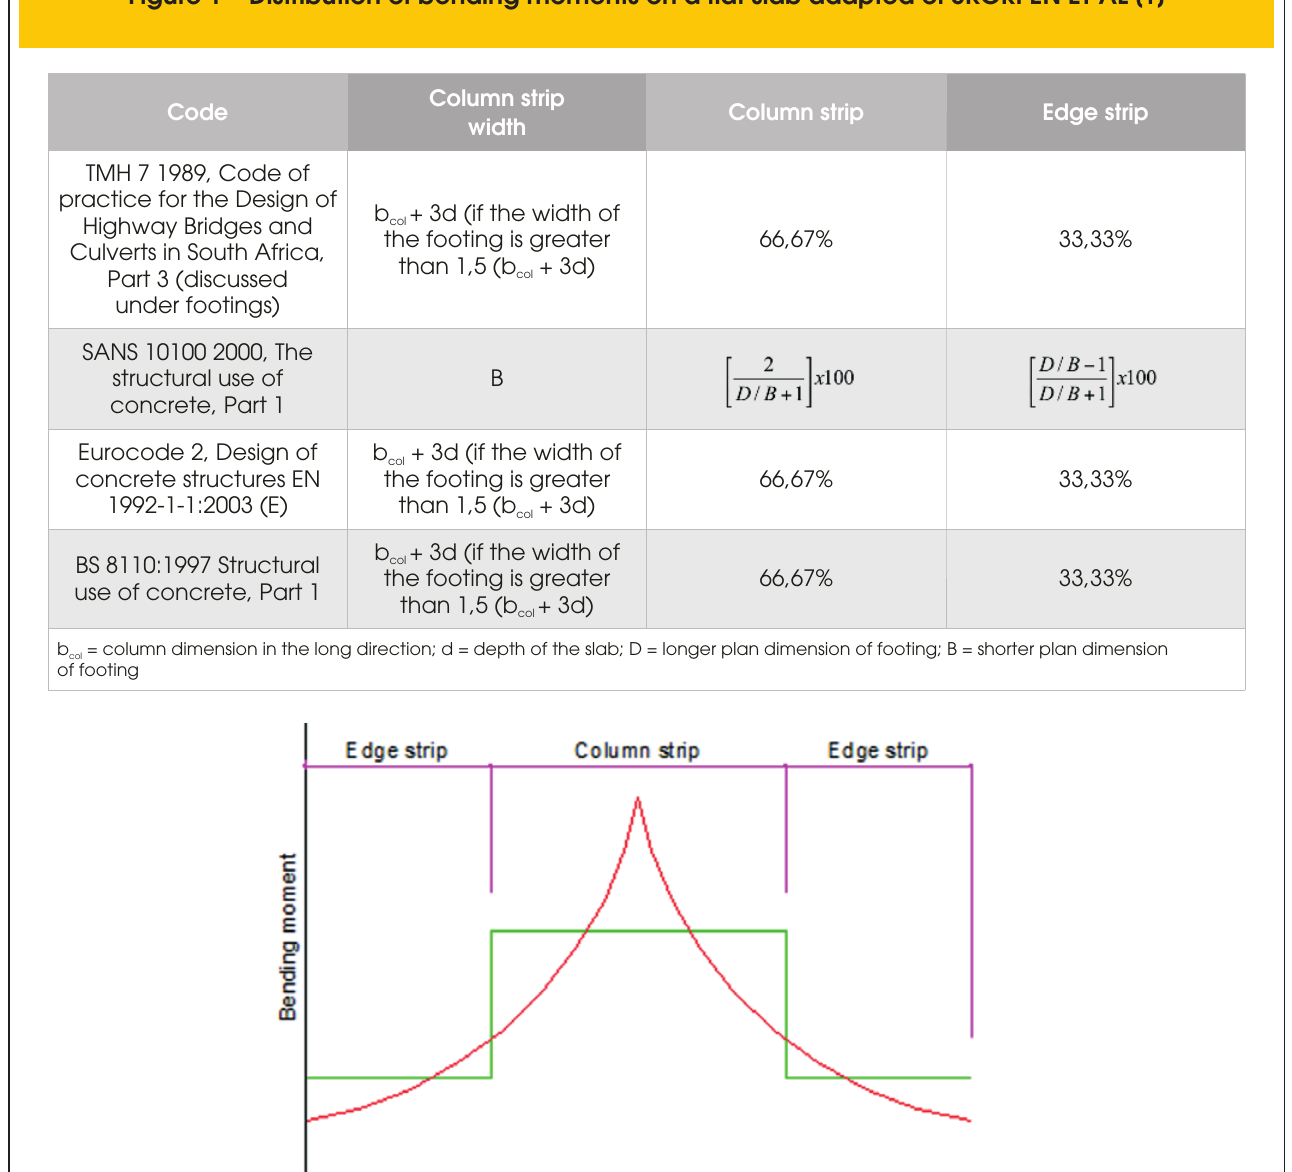
Figure 1 – Distribution of bending moments on a flat slab adapted of SKORPEN ET AL [1]